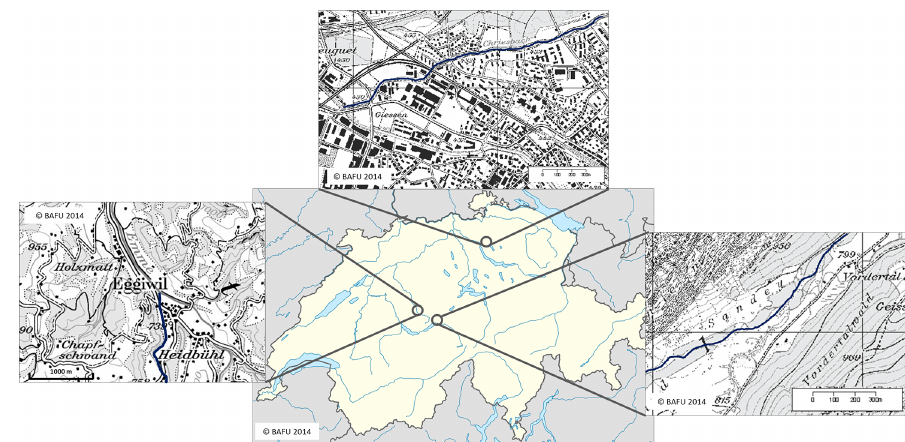
Figure 1. Locations of the Chriesbach (top), the Röthenbach (left), and the Urbach (right) in Switzerland.